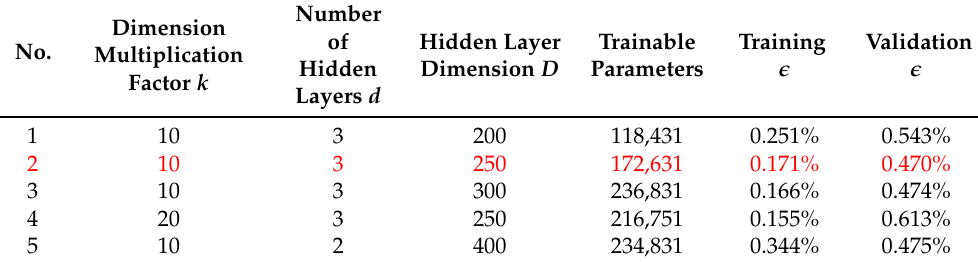
Table 3. Error comparison of different networks in model H 2 tuning tests. The network 2 (in red) is the final